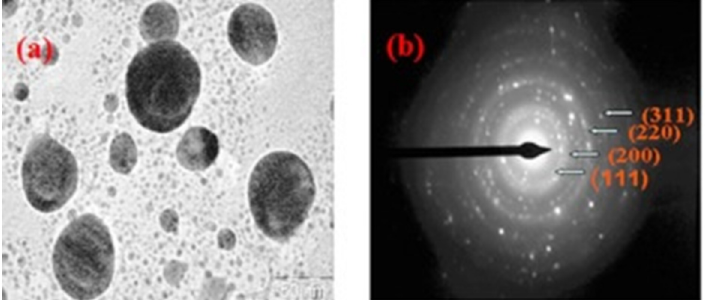
Figure 12. TEM micrograph of ( a ) guar gum capped silver nanoparticles; ( b ) selected area electron diffraction (SAED) pattern [192]. (Reprinted with permission from Vanamudan et al., 2016.)